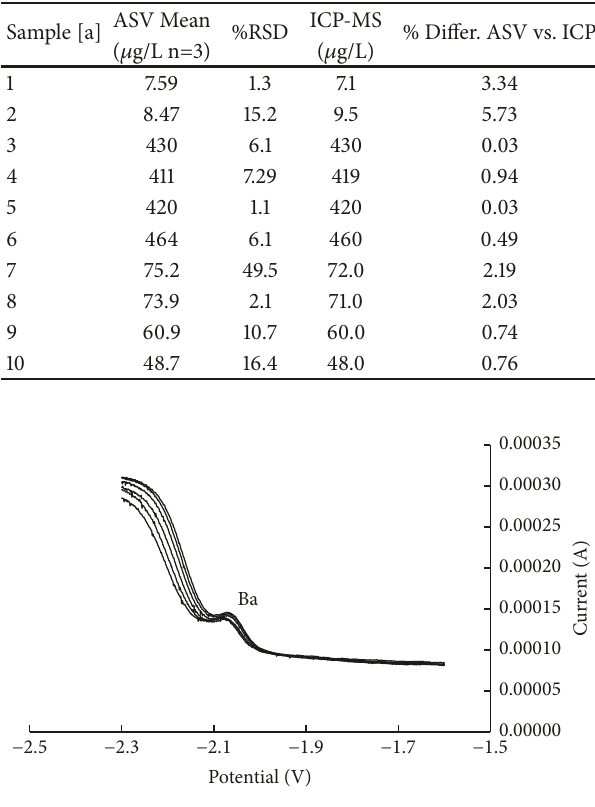
Figure 6: Repeatability results for 20 𝜇 g/L barium concentration on GCE, 0.02MKCl electrolytewith 5 mg/L Hg (0.0015MHNO 3 ),t dep = 30 sec, dp = -2500 mV, and scan rate = 100